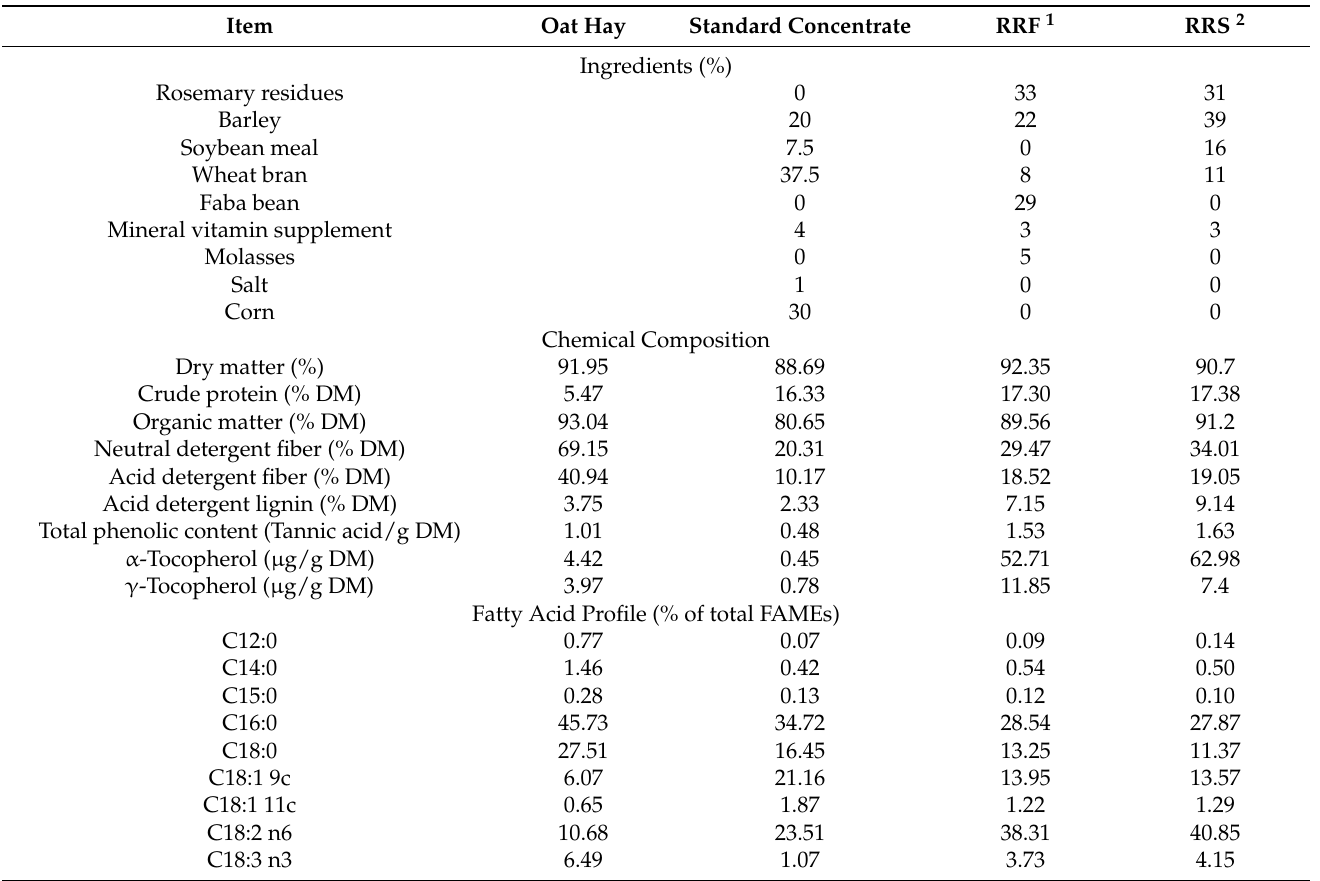
Table 1. Centesimal and chemical composition of experimental